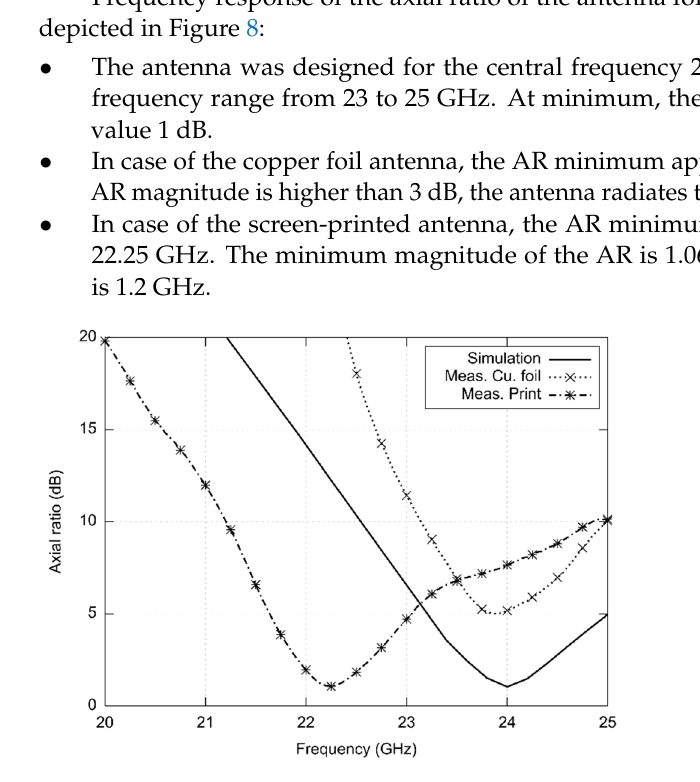
Figure 8. Simulated and measured frequency response of the axial ratio of antennas designed for the 24 GHz ISM band. 24 GHz ISM